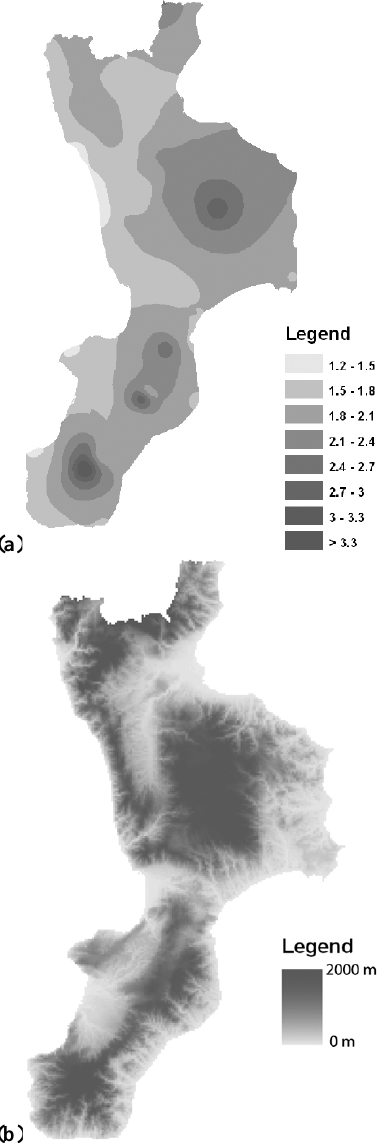
Fig. 3. (a) Mapping of θ h,z parameter; (b) Digital Elevation Model of the Calabria region.